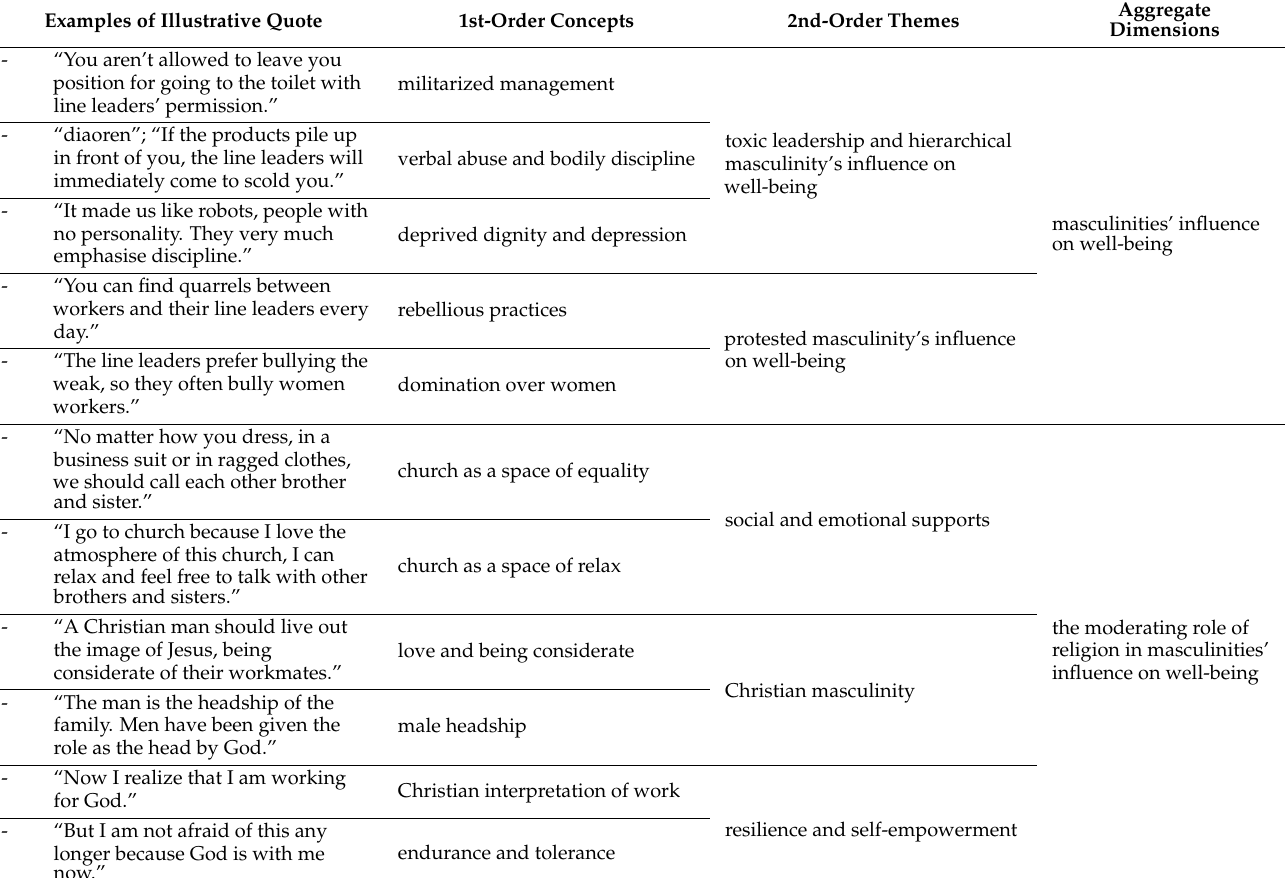
Table 2. Masculinity, religion and well-being